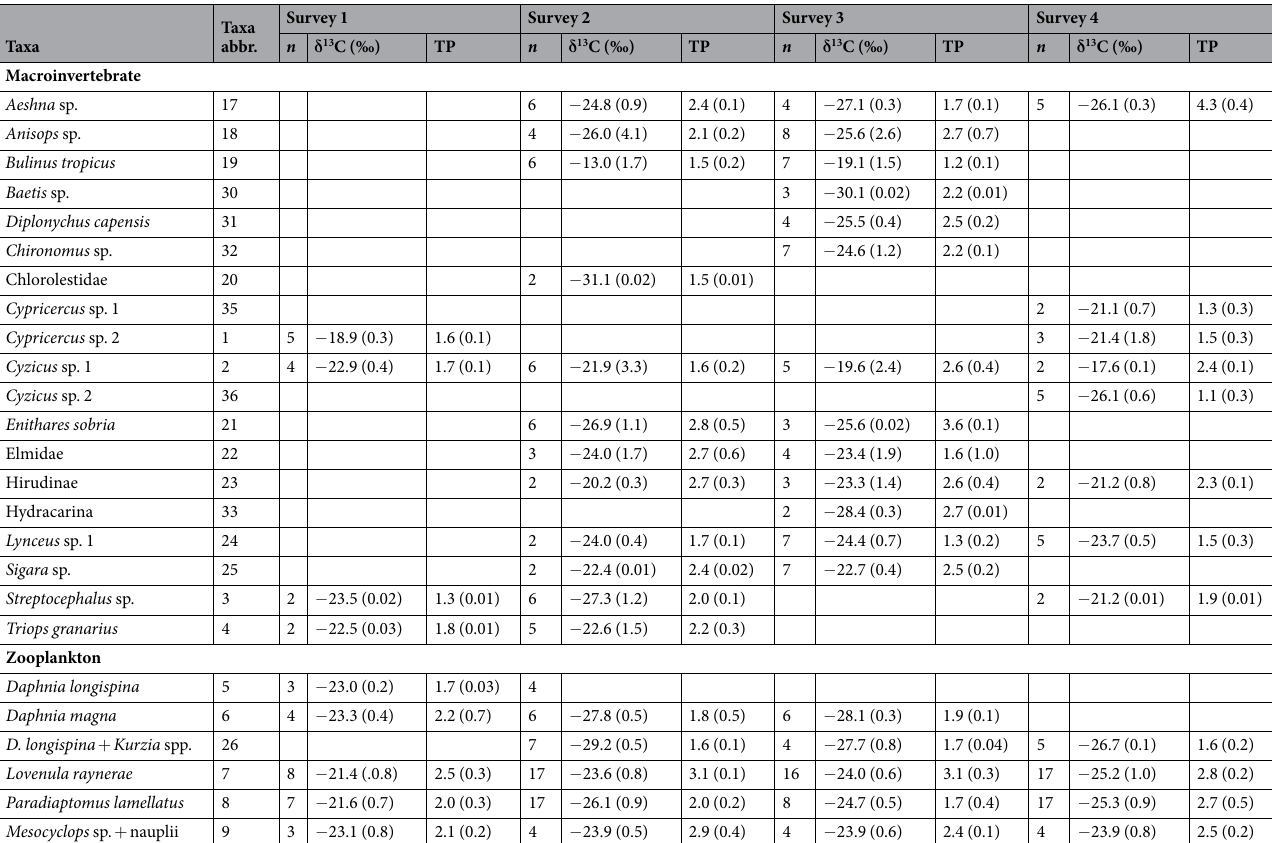
Table 1. Invertebrate taxa sampled from the ephemeral pond over the course of a hydroperiod used for stable isotope analyses. Abbreviations: Taxa abbr. – taxa abbreviation (i.e. assigned sample number), n – number of analysed samples, TP – trophic position.